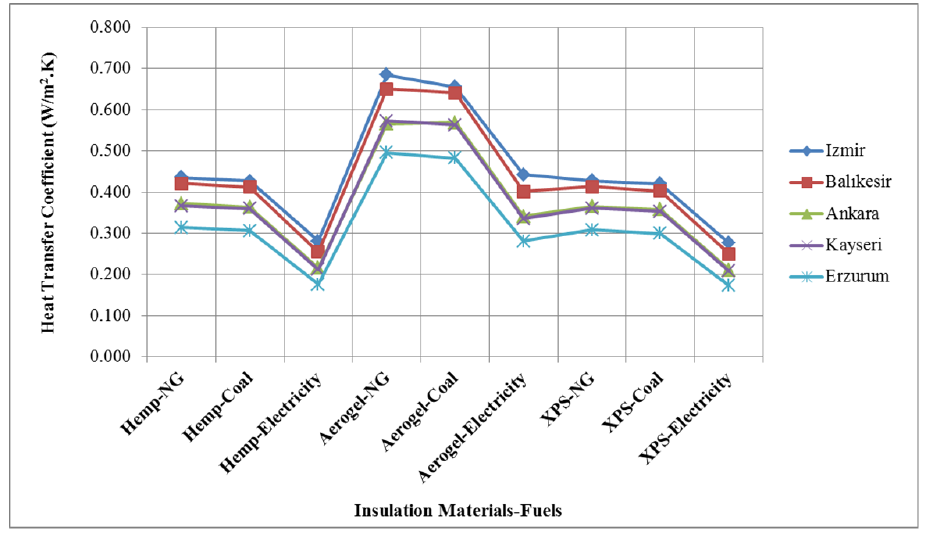
Figure 7. The heat transfer coefficients based on the different energy sources and insulation materials. The highest values of wall indoor surface temperature calculated depending on the uninsulated block bims 4 wall material were calculated as 17.0 ◦ C for Izmir, 16.8 ◦ C for Balikesir, 15.4 ◦ C for Ankara, 14.6 ◦ C for Kayseri, and 14.1 ◦ C for Erzurum. The lowest was determined in hollow brick wall material as 10.7 ◦ C for Izmir, 9.9 ◦ C for Balikesir, 4.9 ◦ C for Ankara, 2.4 ◦ C for Kayseri, and 1.5 ◦ C for Erzurum. The reason for this is that the uninsulated wall heat transfer coefficient has the highest value in hollow brick wall material and the lowest value in block bims 4. These values are shown in Figure 8. The indoor relative humidity values required for mold and moisture formation depending on this wall indoor surface temperature are given in Figure 9. The highest humidity levels required for wall surface mold and moisture formation are 83% for Izmir, 82% for Balikesir, 75% for Ankara, 71% for Kayseri, and 69% for Erzurum. These values were determined in block pumice 4 wall material. The lowest humidity values are 55% for Izmir, 52% for Balikesir, 37% for Ankara, 31% for Kayseri, and 29% for Erzurum. These values were determined in hollow brick wall material. In Block Bims 4, wall indoor surface temperature temperatures were found at the highest value and in hollow brick wall material at the lowest